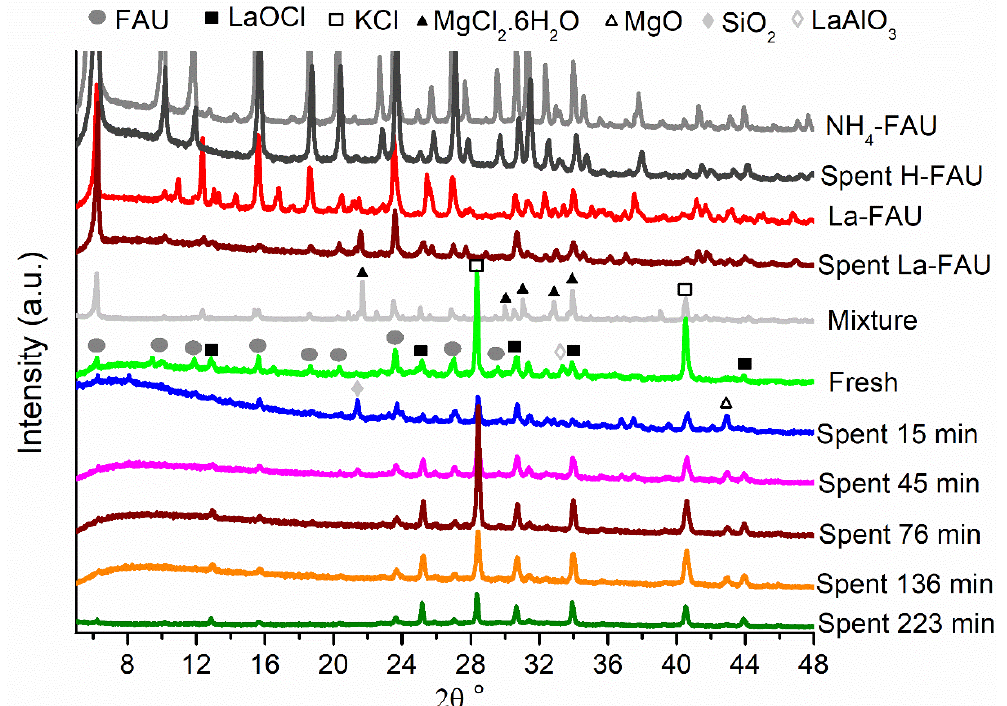
Figure 6. X-ray diffraction patterns of FAU-zeolite, La-FAU, as well as S-ACl catalyst before and after the ethane ODH reaction in TOS: 15, 45, 76, 136, and 223 min (patterns are shifted along the y-axis by an increment of 2500 a.u.).